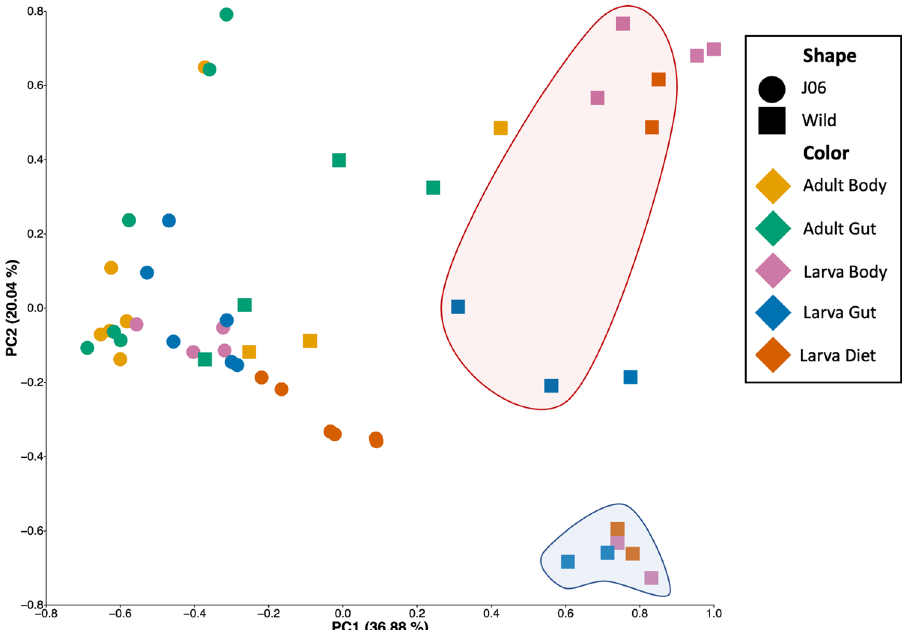
Figure 2. PCoA plot of generalized UniFrac distances. Blue (Myiasis 1, calf leg) and red (Myiasis 2, adult cow ear) circled samples were collected from two cows approximately 8.7 km apart, highlighting the possible microbial diversity that can occur between myiases and the impact on the larval